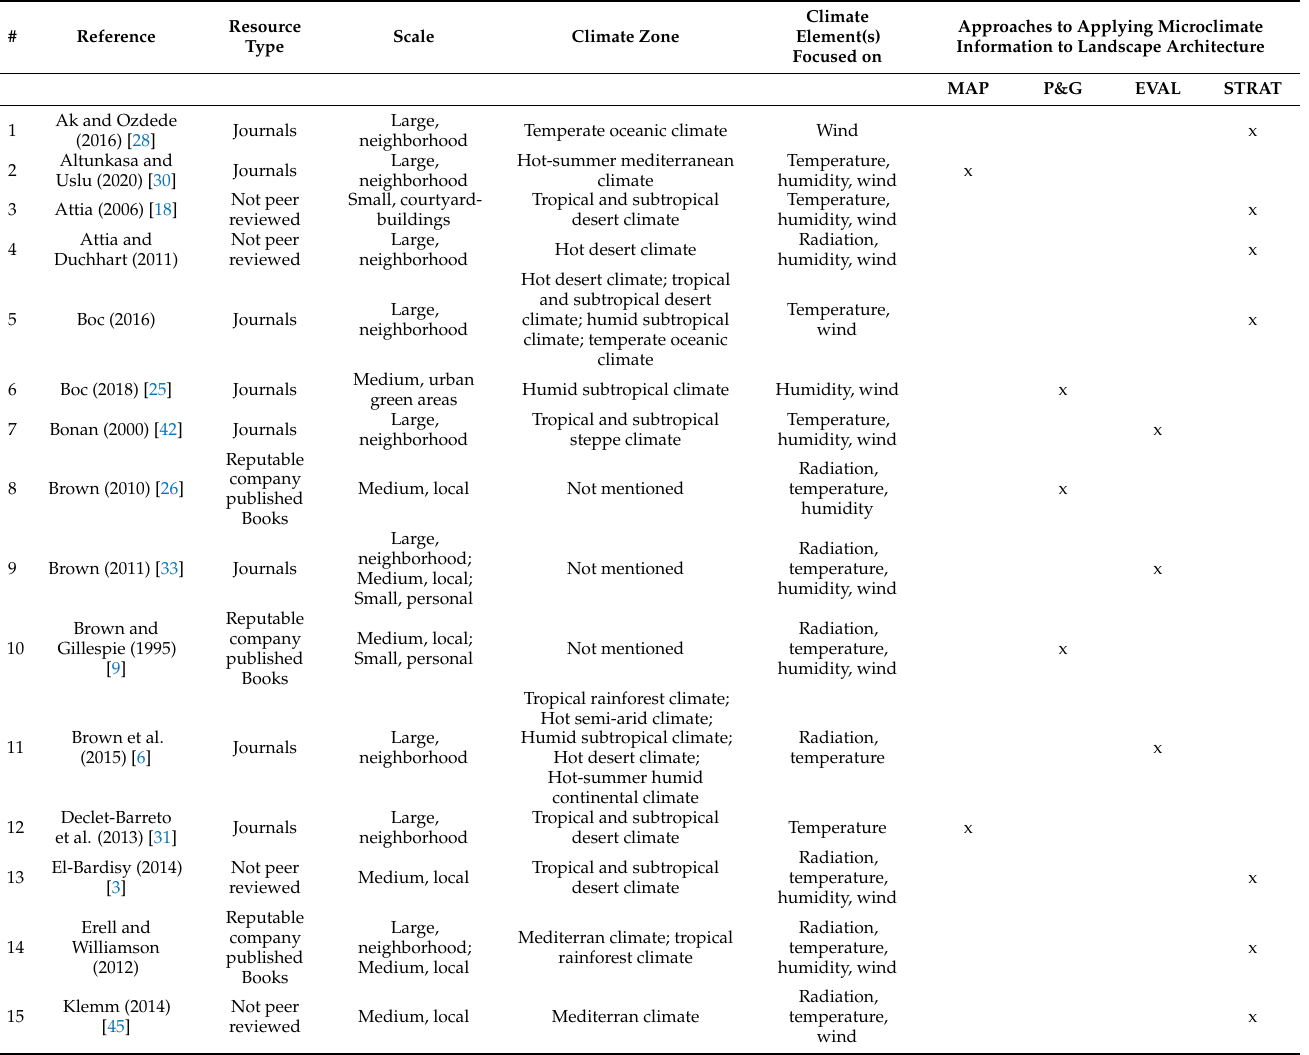
Table 1. Characteristics of included